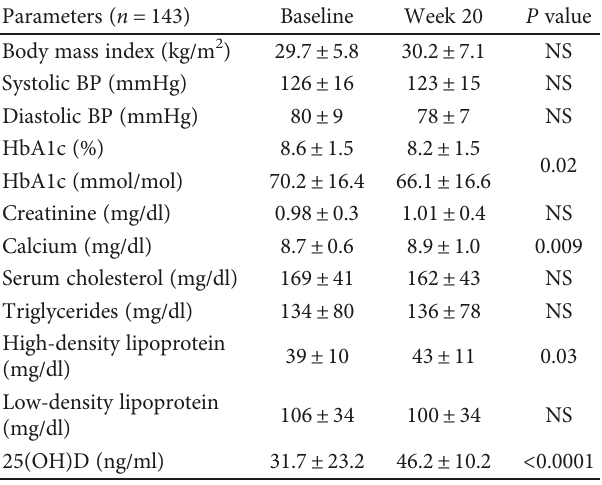
Table 2: Baseline and end of trial anthropometric and metabolic parameters after administration of vitamin